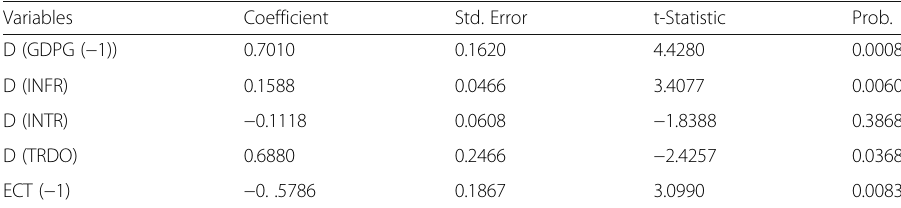
Table 5 ARDL Short Run Approach Variables Coefficient